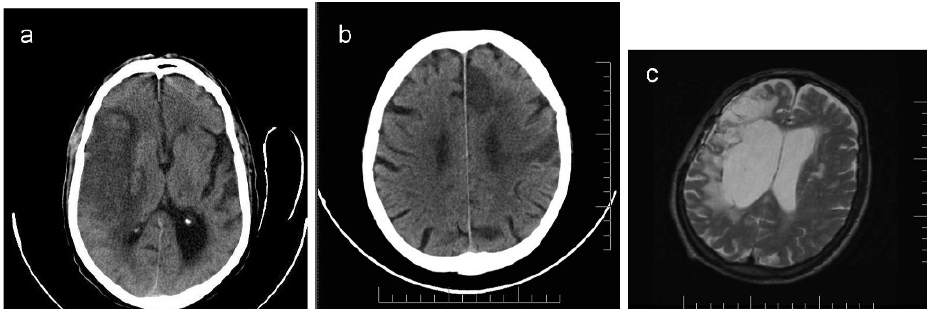
Figure - 1 a. CT scan from patient 1. Note an ischemic stroke of the M1 segment of the middle cerebral artery with a small hemorrhagic transformation in the perforating arteries territory. b. CT scan from patient 2 showing infarcts in branches of left anterior and middle